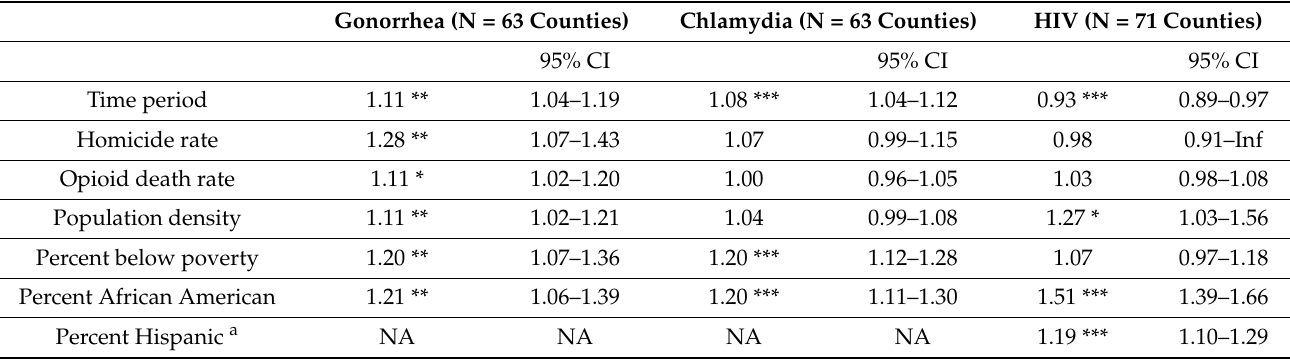
Table 3. Estimates of fixed effects from the negative binomial mixed model regression analysis for each of the dependent variables for Urban Counties (gonorrhea, chlamydia, and HIV rates). Urban counties were defined as those with a population density equal to or greater than 518 persons per km 2 (200 persons per mi 2